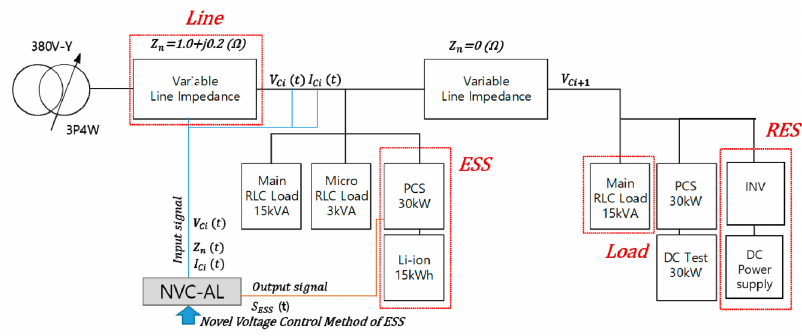
Figure 22. Test configuration.